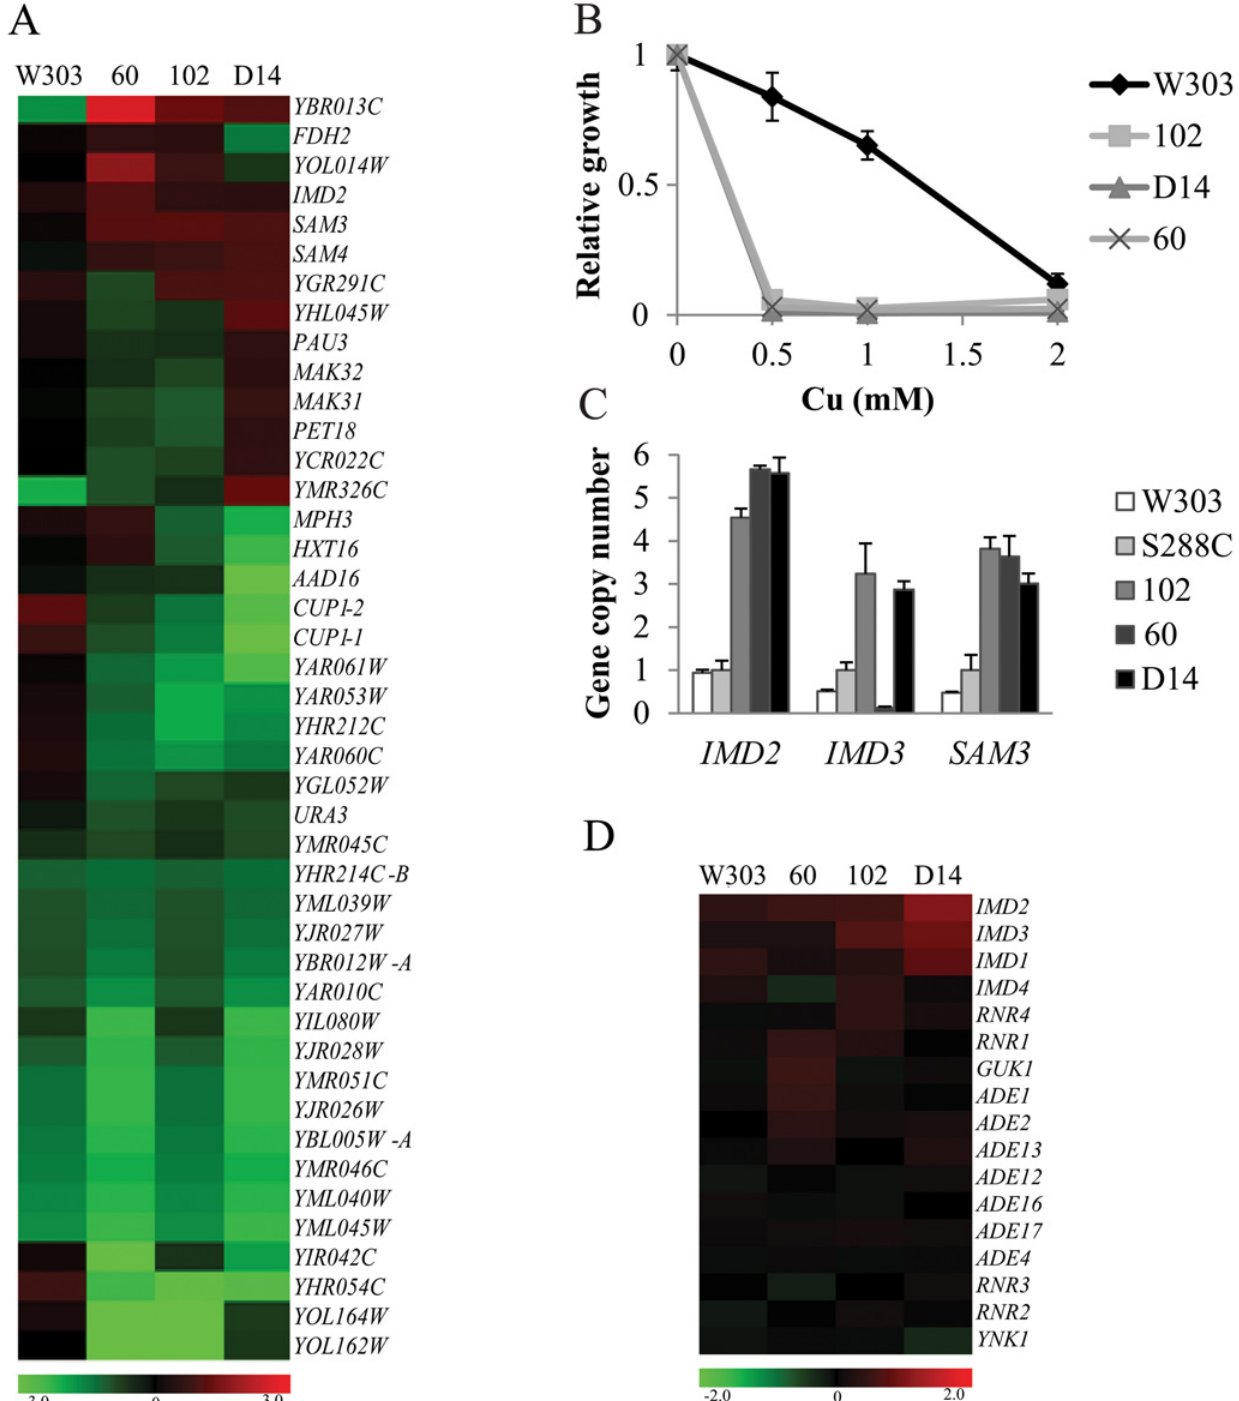
Fig 2. Opportunistic strains showed altered CN of specific genes. A) Genes that showed altered CNV in the three opportunistic strains were clustered and the heat map obtained (Mev software) is represented. B) Evaluation of growth with different concentrations of copper was performed in microtiter plates in YPD media. Maximal growth for each Cu concentration was relativized to YPD without Cu for each strain. Average and standard deviation of triplicates is represented C) Gene copy number was determined by qPCR. Data was normalized with haploid strain S288C. Average and standard deviation of triplicates is represented. D) Heat map detail of genes that belong to de novo purine biosynthetic pathway (Mev software).